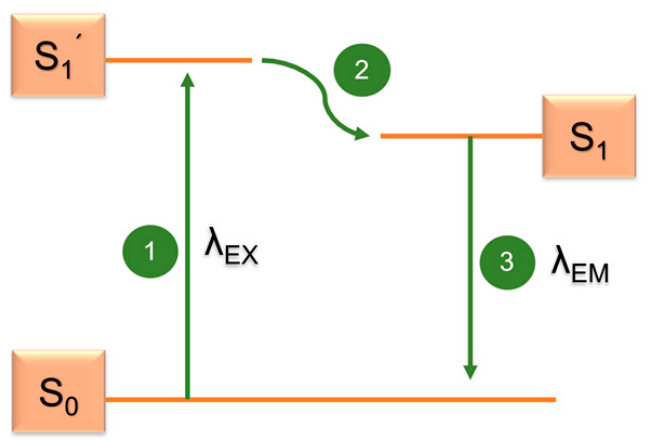
Figure 4. Jablonski diagram describing the phenomenon of fluorescence (modified from Johnson [110]).